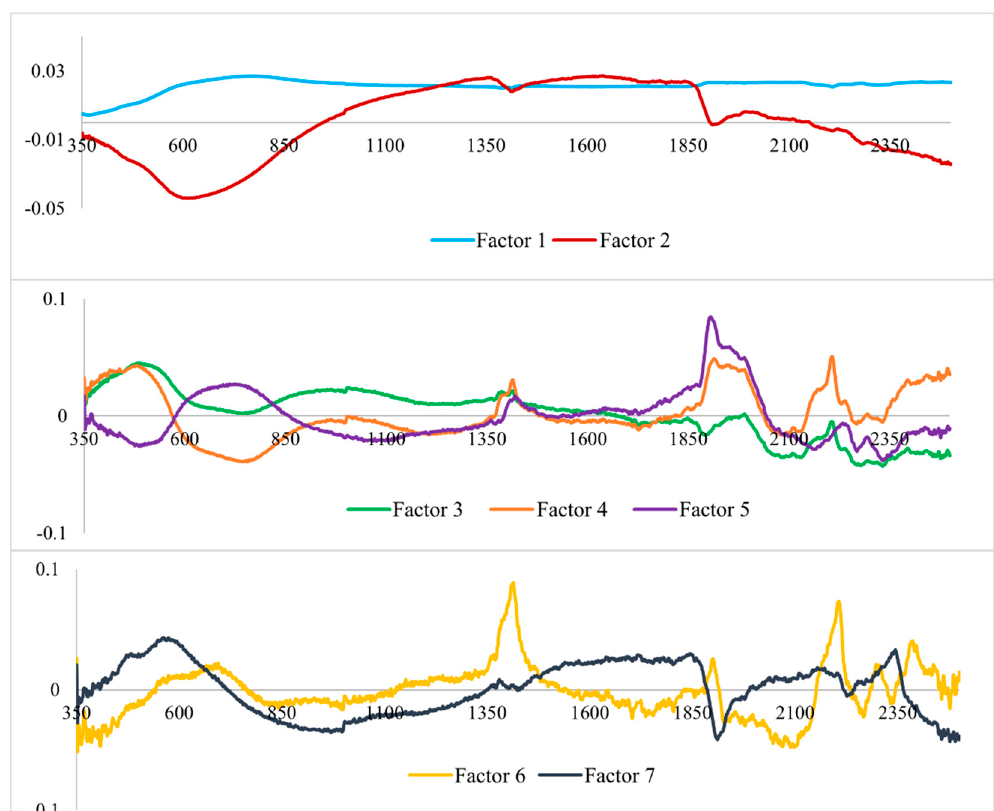
A2 with a smoothed spectrum, and a maximum of 14 bands using all the samples with the Figure 11. PLSR model loadings for A1 using smoothed spectral data in estimating soil organic carbon. same spectral treatment.